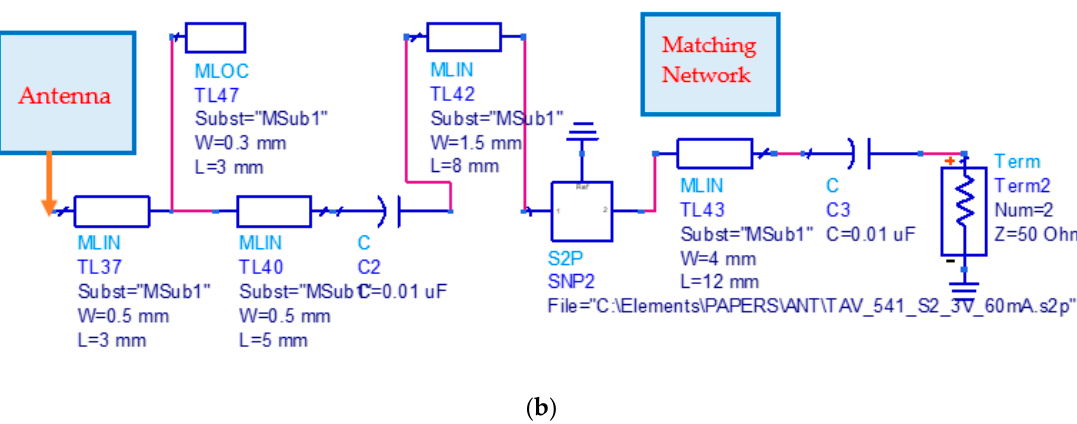
Figure 8. Circular patch active receiving antenna. ( a ) Smith chart, S11; ( b ) Matching network.